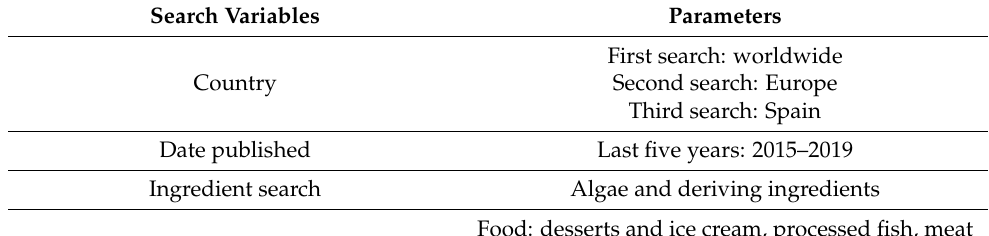
Table 1. Search strategy used on Mintel Global New Product